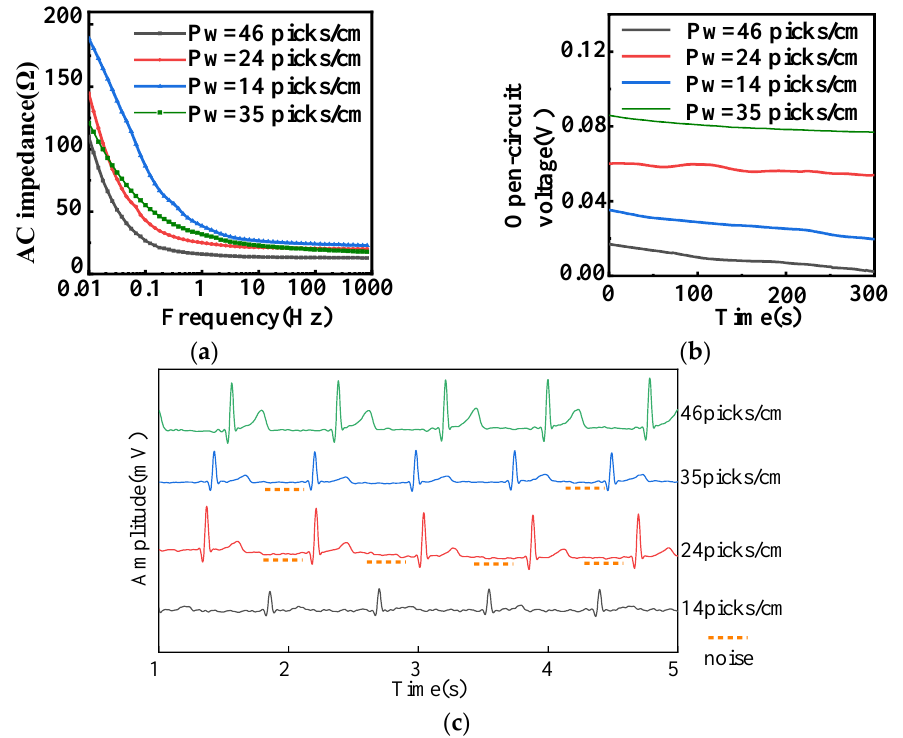
Figure 6. ( a ) AC impedance, ( b ) open-circuit voltage, and ( c ) static ECG signals of different weft densities with 4 cm diameter and 12/5 sateen for fabric electrodes. (Pw represents the weft density).